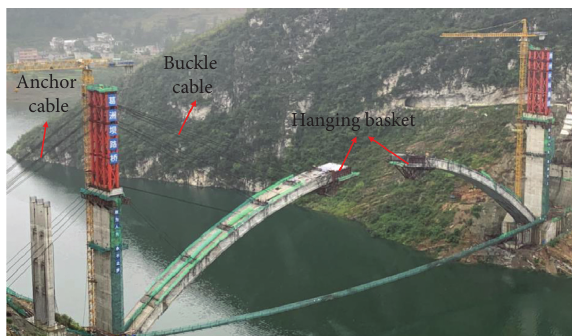
Figure 10: Move the hanging basket to the pouring position of segment i + 1 of the arch ring.